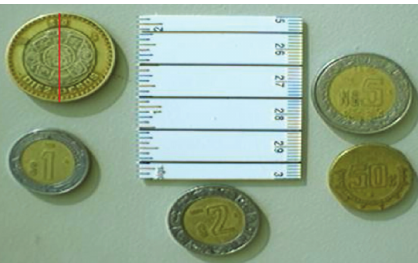
Figure 9: Diameter of the five different currencies used to validate the developed algorithm.